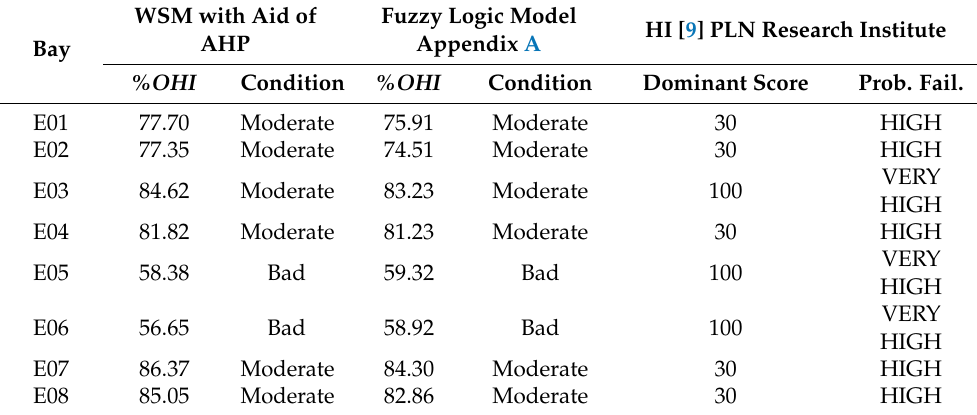
Table 13. %HI comparison between WSM with aid of AHP, Fuzzy logic model and dominant HI.